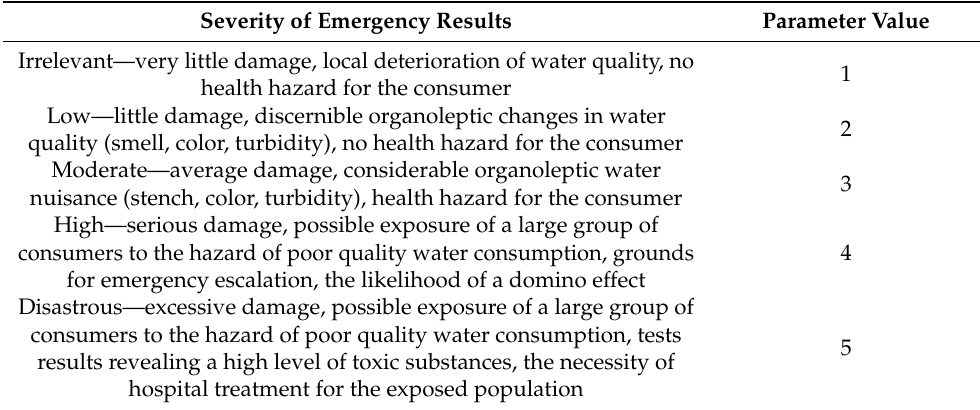
Table 2. The categorization of the parameter of results (C) (own study based on [49], modified by [48]).